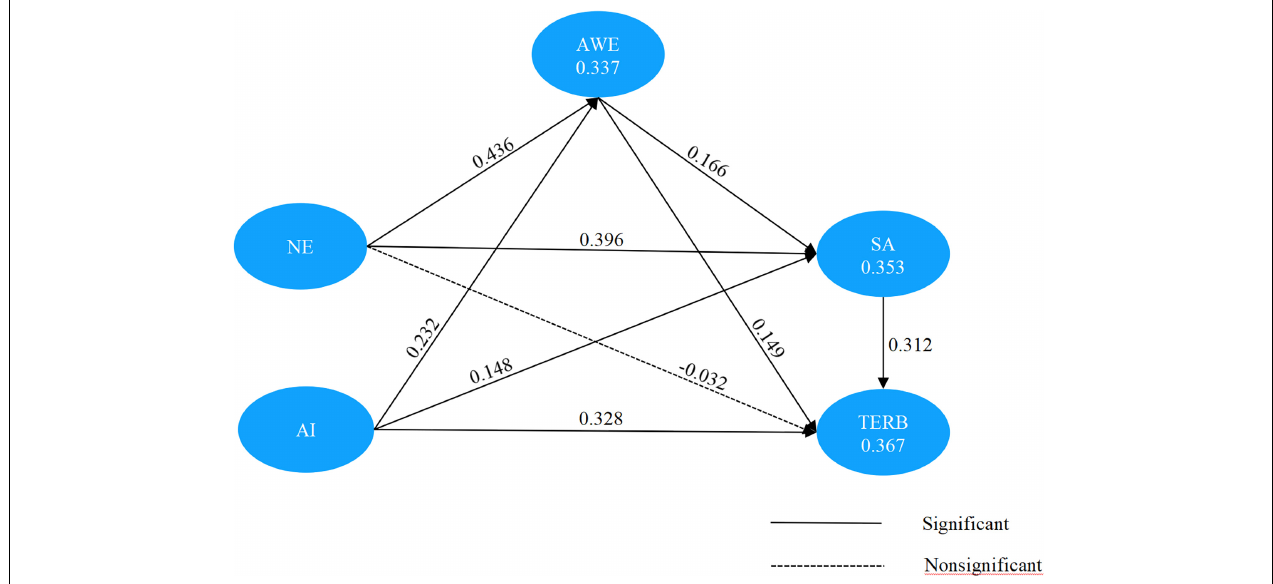
FIGURE 4 | Completely standardized path coefficients among NE, AI, AWE, SA, and TERB. NE, the perception of the natural environment; AI, the perception of the availability of infrastructure; AWE, the experience of awe; SA, tourists’ satisfaction; TERB, tourists’ environmentally responsible behavior.